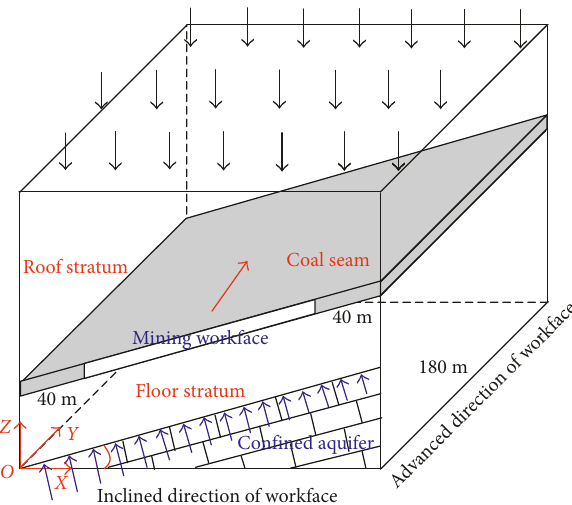
Figure 1: 3D fluid-solid coupling numerical calculation model for an inclined coal seam with strike longwall